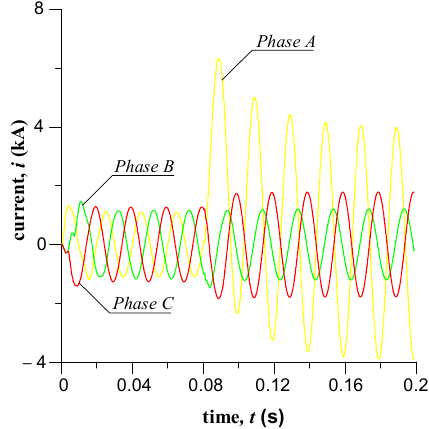
Figure 8. The phase current waveforms in the middle of the line. Since the load of the power supply line is unbalanced, the phase current amplitudes in the steady state have different values. For example, in the middle of the line, the current amplitude for phase A is 1 kA, for phase B it is 1.1 kA, and for phase C it is 1.3 kA. After a single-phase short circuit occurs at point A at the end of the line, at the time t = 0.08 s from the moment of switching on the voltage, the surge current of this phase in the middle part of the line reaches 6.25 kA, and the current amplitude in the steady state is 4 kA. Figure 9 shows the waveforms of the phase currents at the end of the line when it is on and then switches at t = 0.08 s to the single-phase short-circuit at the end of the line at point